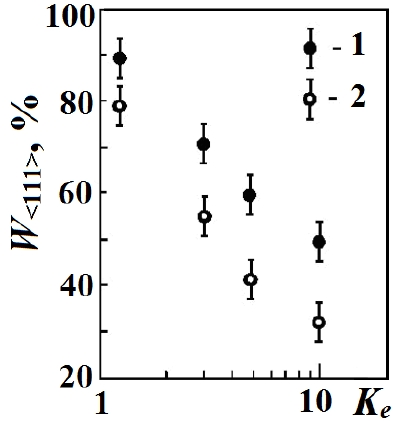
Annealing of Bi–Sb extruded crystals causes a further decrease in the W <111> values.